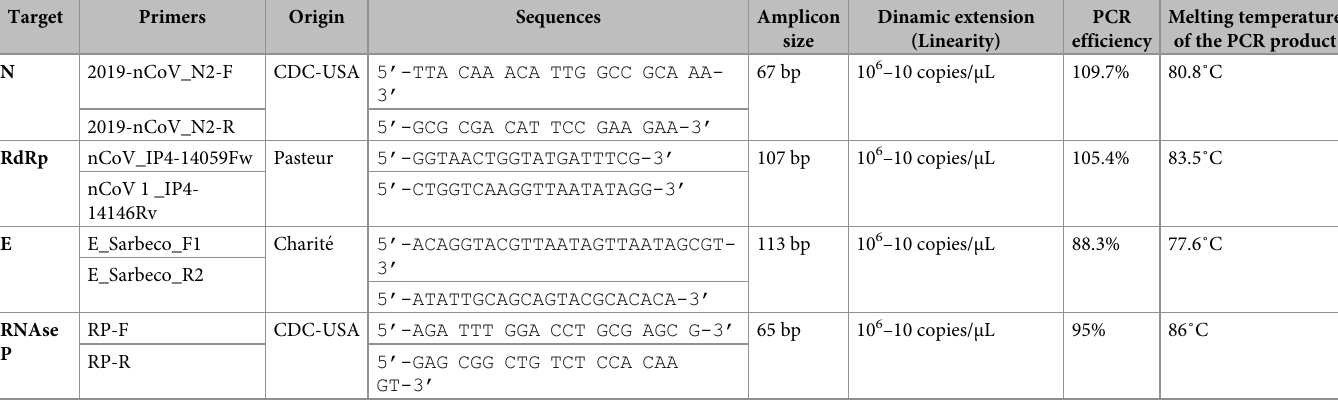
Table 1. Primers, linearity and melting curve parameters for SARS-CoV-2 and human RNAse P